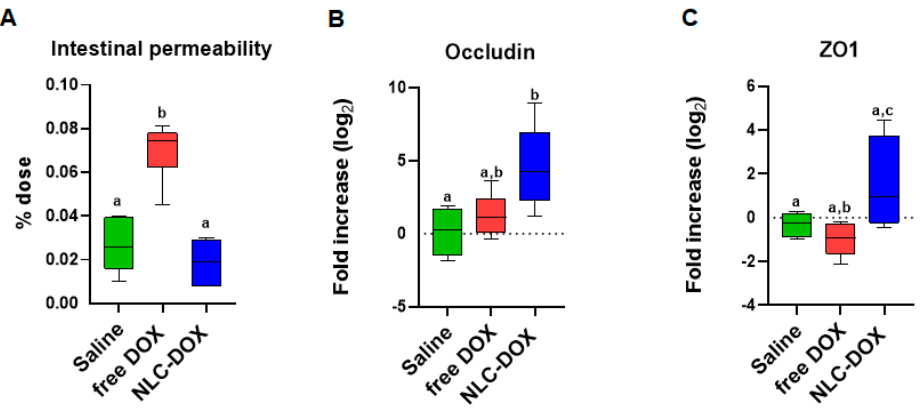
Figure 6. Intestinal permeability was preserved in NLC-DOX treatment. ( A ) Intestinal permeability by DTPA-Tc99m and mRNA expression of ( B ) Occludin and ( C ) ZO1 by real time RT-PCR in the ileum were evaluated 3 days after injection of saline, free DOX or NLC-DOX. Statistical analysis was performed by using the ANOVA test, followed by the Tukey test. Different letters represent p < 0.05. N = 10 animals per group. Data are a pool from 2 experiments performed. Abbreviations: DOX, doxorubicin; NLC, nanostructured lipid carrier.